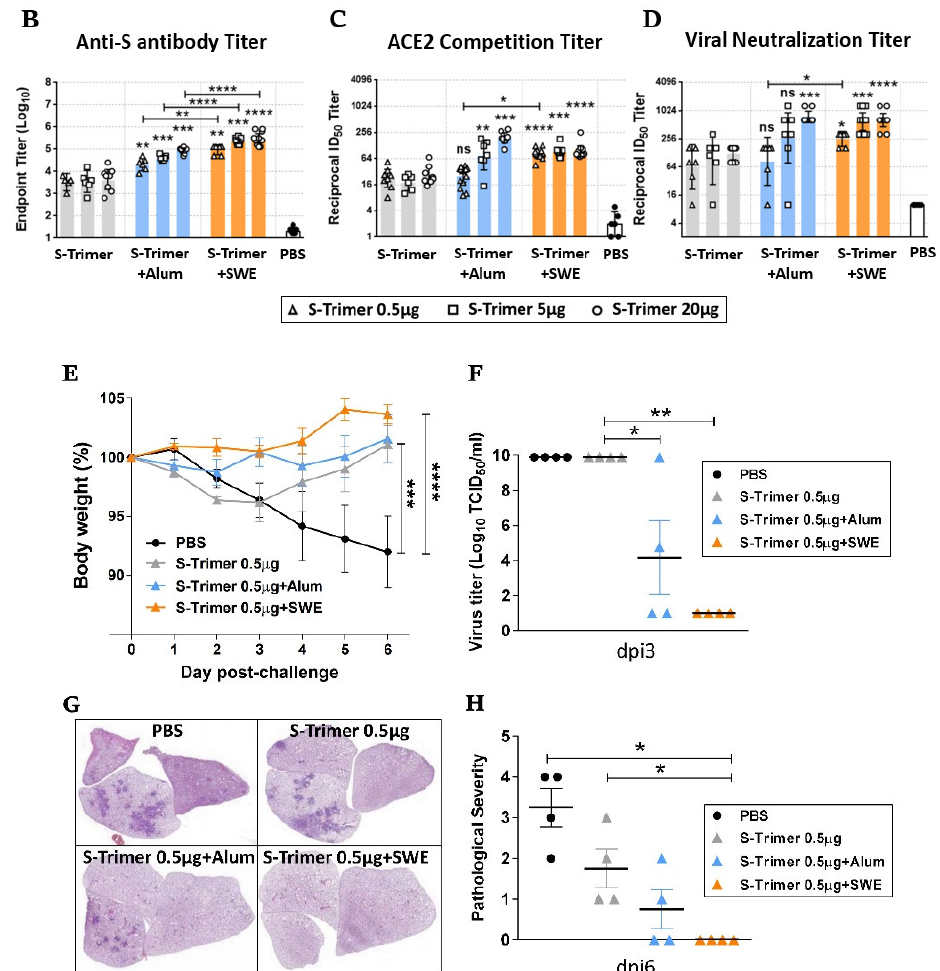
Figure 7. Protective efficacy of S-Trimer immunization against SARS-CoV-2 infection in Syrian hamsters. ( A ) Schematic showing the schedule of S-Trimer vaccination, SARS-CoV-2 infection, and blood collection for the hamster study. Syrian hamsters ( n = 6–10/group) were administered with nonadjuvanted or adjuvanted S-Trimer 0.5 µ g twice via intramuscular routes on Day 0 and 28. PBS-injected group as blank control. Serum was collected by gingival blood sampling on Day 0, 28, and 42. Syrian hamsters were intranasally infected on Day 45 with 1 × 10 5 TCID50 live SARS-CoV-2 virus. The humoral immune responses were evaluated based on ( B ) anti S-Trimer Endpoint IgG titers, ( C ) ACE2 competition ELISA titers, and ( D ) wild-type SARS-CoV-2 virus neutralization titers. ( E ) Body weight change (%) of the hamsters was recorded every day after SARS-CoV-2 infection. ( F ) Virus titers in the lungs of SARS-CoV-2-infected hamsters at 3 days post-infection (dpi3) were determined by TCID50 assay. ( G ) Representative histopathology images of H&E staining from the lung sections of infected hamsters at 6 days post-infection (dpi6), in which purple indicates areas of inflammation. ( H ) Pathological severity of lung lesions was evaluated by the percentage of inflammation area of each section. Symbols represent individual animals; bars indicate geometric mean ± 95%CI of endpoint titers and ID 50 titers for each group; horizontal lines indicate mean ± SD. For statistical analysis of antibody titers, virus titers, and pathological severity, significant differences compared between groups by two-tailed Mann–Whitney test. The comparisons of body weight change (%) were made by two-way ANOVA with multiple comparison tests. * p < 0.05, ** p < 0.008, *** p < 0.0005, **** p < 0.0001, ns: not significant.